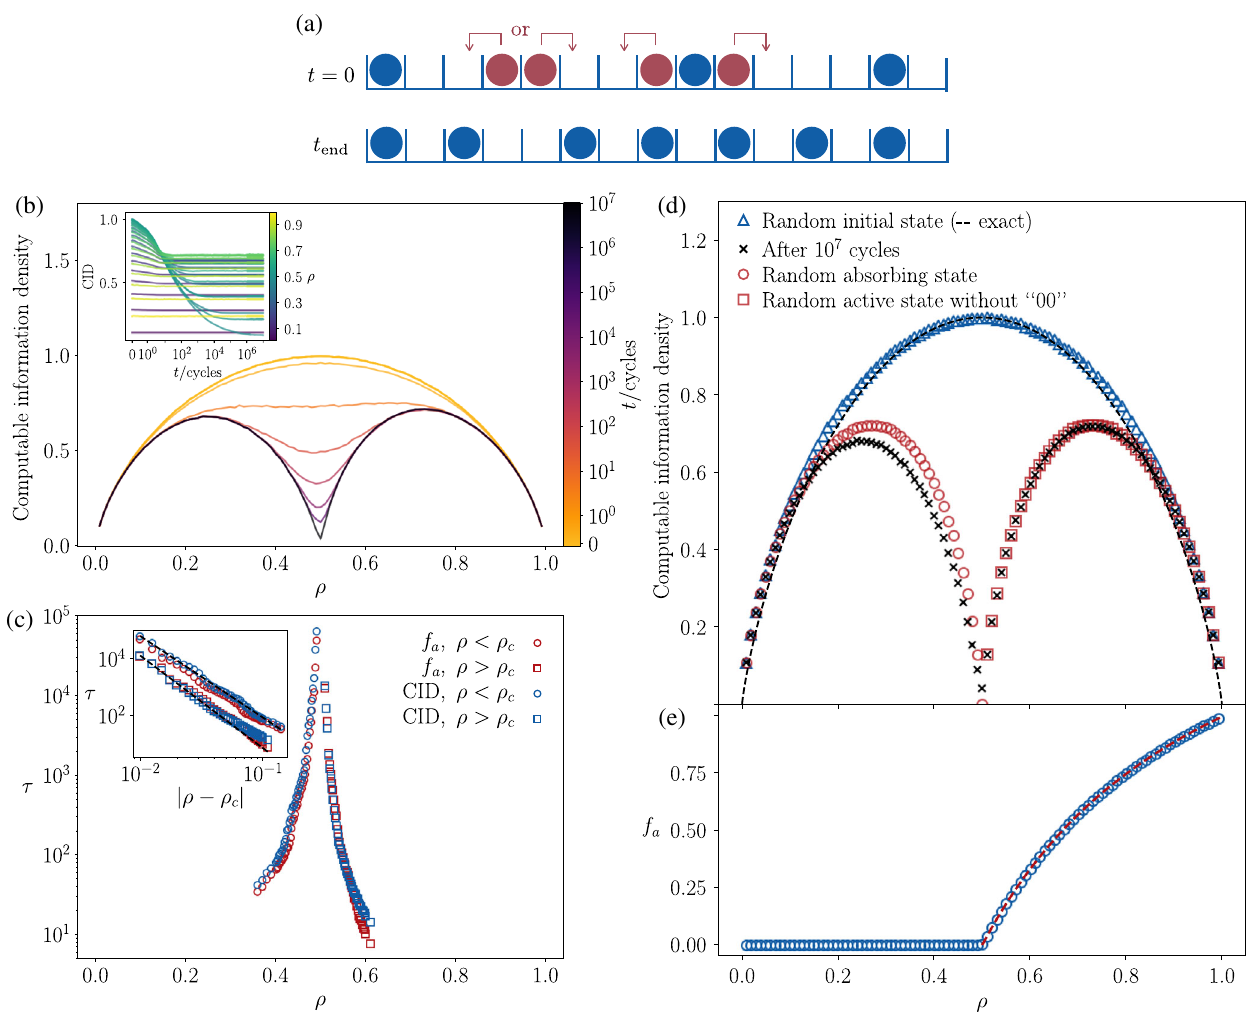
FIG. 1. The 1D conserved lattice gas model of size L ¼ 10 5 . (a) At time t ¼ 0 the system is in an active randomly sampled state (active sites in red) and the possible moves prescribed by the dynamics are indicated by the arrows. When the particle density is below the 0 . (b) Time dependence of the CID critical density ρ , the system relaxes to an absorbing state, such that the fraction of active sites f c a ¼ as a function of particle density ρ , a cycle corresponds to L randomly attempted moves. The system orders as a function of time, 0 . 5 . The inset shows the CID time-evolution profile for several densities. developing a cusp minimum at the critical density ρ c ¼ (c) Characteristic time τ as a function of density ρ , as measured by the decay of f and CID, exhibiting a divergence near ρ , in line with a c the cusp minimum in panel (b). Data are from an independent set of calculations in the neighborhood of ρ , averaged over ten c independent initial conditions. The inset shows τ as a function of j ρ − ρ , exhibiting identical power-law divergence and critical c j exponent ν ¼ 3 (cid:2) 0 . 3 from both measures. Lines of best fit (dashed black lines) were obtained by bootstrapped minimum mean-square k error fits using a robust covariance estimator [38,39]. (d) Comparison of the CID for random initial states (blue triangles), states found by generated by Monte Carlo the dynamics after 10 7 cycles (black crosses), random (uniformly sampled) absorbing states below ρ c sampling (red circles), and active states without “ 00 ” pairs above ρ (red squares) also generated by Monte Carlo sampling. (e) Fraction c of active sites as a function of ρ , red dashed line is the exact solution from Ref.